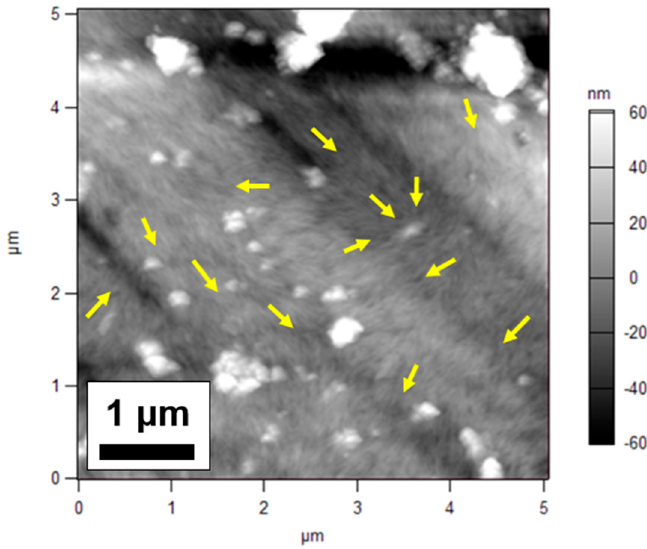
Figure 7. Atomic force microscope (AFM) height retrace image of PES support with 0.5 mg TOCNs deposited on the surface. Arrows indicate various directions of orientation of TOCNs.